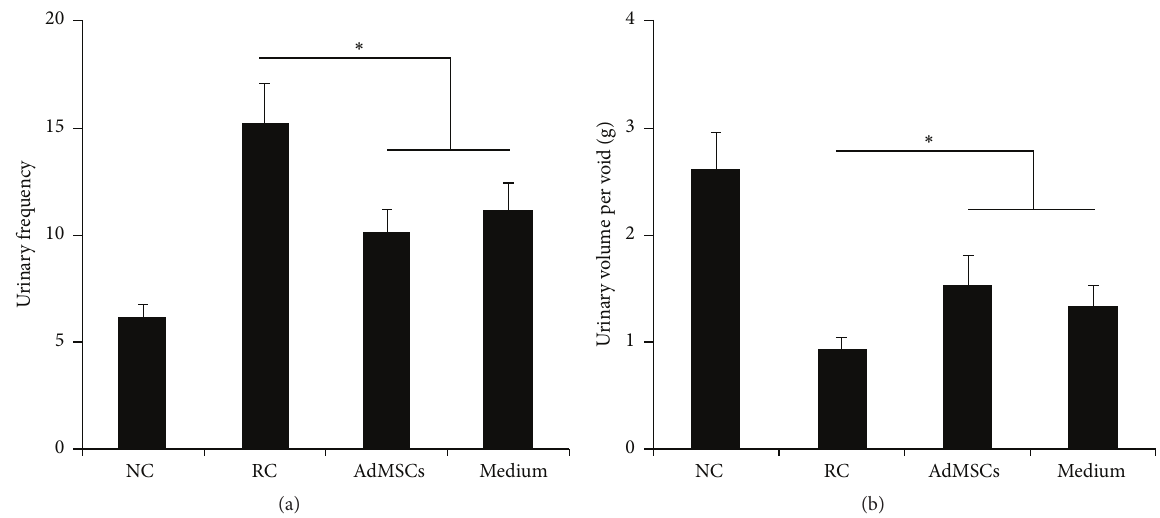
Figure 3: Results of metabolic cage investigation. ∗ 𝑃 < 0.05 compared with the RC group. There is no significant difference between AdMSCs group and Medium